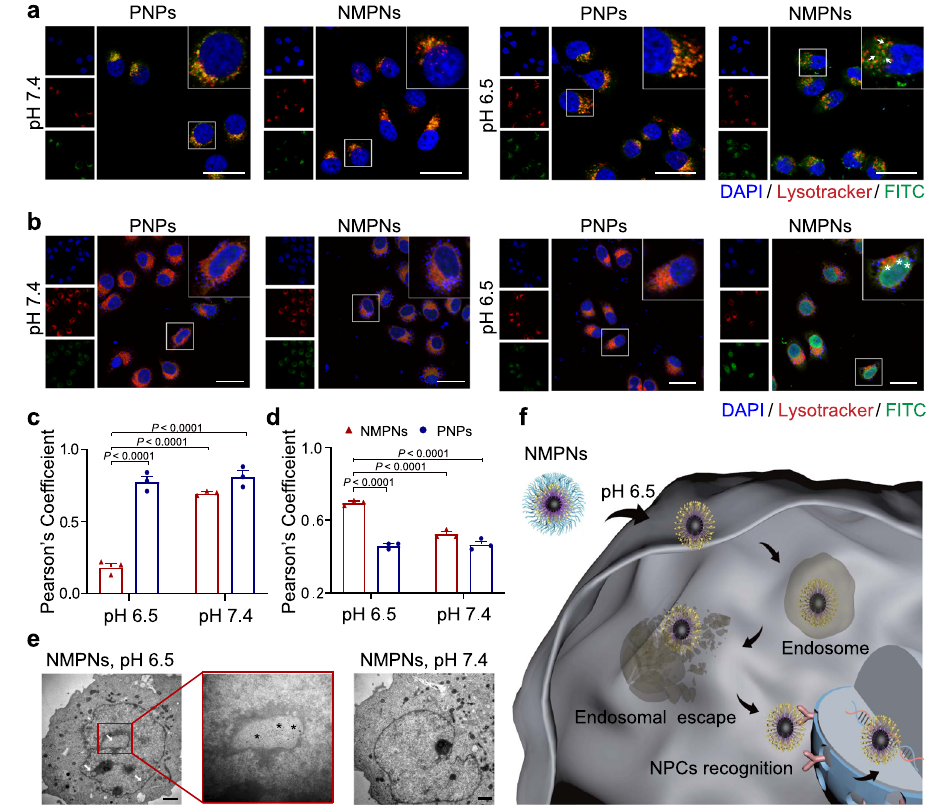
Fig. 3 | pH-dependent cell nucleus-targeting of NMPNs. a CLSM images of intracellular localization of FITC-labelled NMPNs and FITC-labelled PNPs after incubated for 6h under different pHconditions. Scale bar: 20 μ m. Arrows indicate NMPNs in the cytoplasm after the escape from endosomes in cisplatin-resistant Huh7cells. b CLSMimagesofintracellularlocalizationofFITC-labelledNMPNsand FITC-labelled PNPs after incubated for 12h under different pH conditions. Scale bar: 40 μ m. Asterisks indicate NMPNs in the nucleus of cisplatin-resistant Huh7 cells. c Quantitative analysis of the colocalization between lysotracker and FITC-